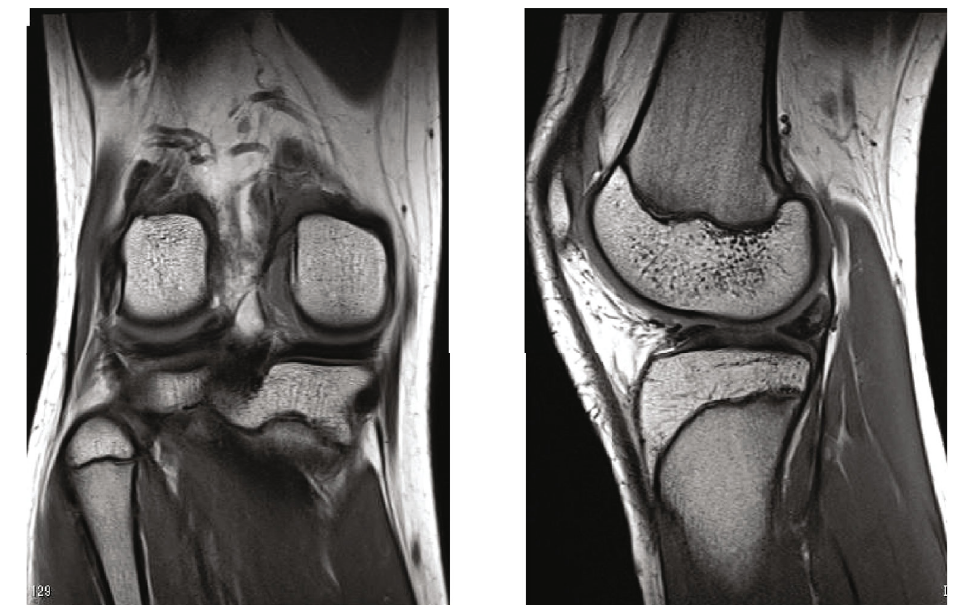
Figure 2: Magnetic resonance imaging (proton density-weighted image) shows high signal in the posterior segment and an increase in its